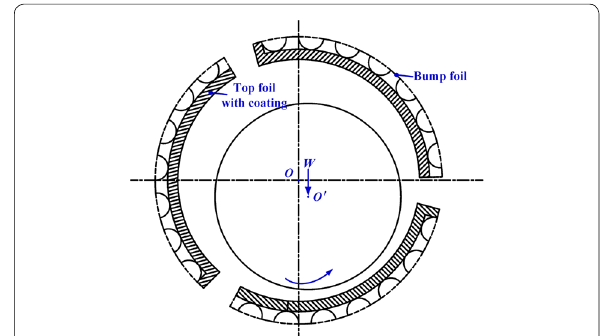
Figure 10 Structural features of a compliant fluid foil bearing